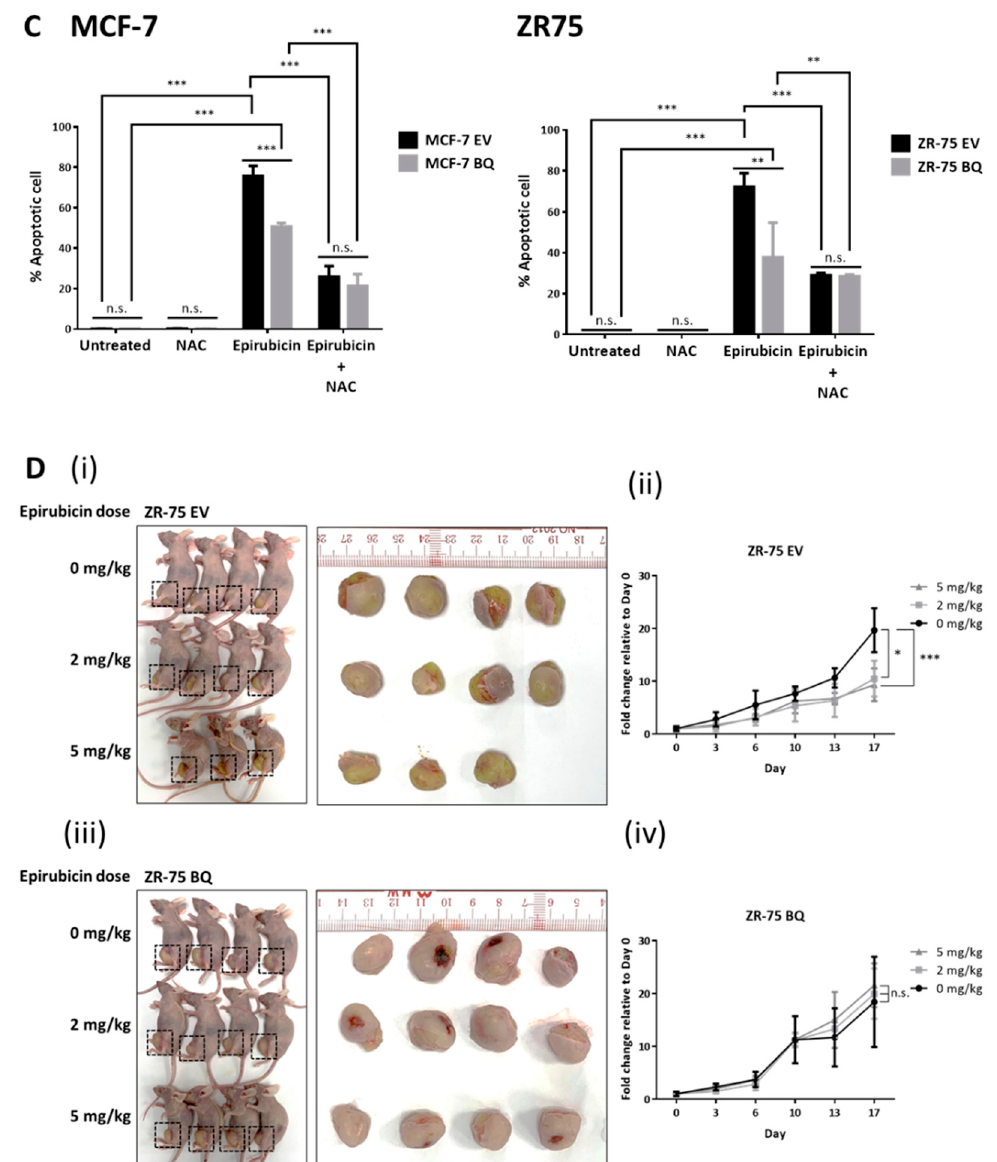
Figure 4. BQ overexpression contributes to epirubicin resistance. ( A ) Clonogenic assay was performed to assess the effect of epirubicin on the cell viability of control cells and BQ overexpressing cells. Cells were treated with different doses of epirubicin for 14 days. The cells were stained with crystal violet (left panel). The results (right panel) represent the average of three independent experiments. Data presented as mean ± SD and analyzed by two-way ANOVA (* p < 0.05; *** p < 0.001). (N = 3) ( B ) The effect of antioxidant N-Acetyl Cysteine (NAC) on the level of ROS induced by epirubicin. BQ-overexpressing cells or control cells were treated for 24 h with 5 µM NAC, 1 µM epirubicin alone or combined. Untreated cells served as control. Cells were stained with CellROX Deep Red reagent and analyzed for ROS levels by flow cytometry. Data were analyzed by FlowJo software. The mean fluorescence values were represented as relative ROS level compared to untreated control cells. (Student’s t -test, mean ± SD, * p < 0.05; ** p < 0.01; *** p < 0.001; n.s. nonsignificant) (N = 3) ( C ) The effect of NAC on apoptosis induced by epirubicin. BQ overexpressing cells or control cells were treated for 24 h with 5 µM NAC, 1 µM epirubcin alone or combined. Untreated cells served as control. Apoptosis was measured by Annexin V Alexa Fluor 647 stain plus SYTOX Blue Dead cell stain staining, followed by flow cytometry analysis. Representative cytofluorimetric plots were shown in supplementary Figure 5. Bars show the percentages of cells that were apoptotic cells. Results are expressed as mean ± SD. (Student’s t -test, mean ± SD, ** p < 0.01; *** p < 0.001; n.s. nonsignificant) (N = 3) ( D ) Tumor xenograft models in mouse used to assess BQ overexpression on epirubicin resistance. ( i ) Mice